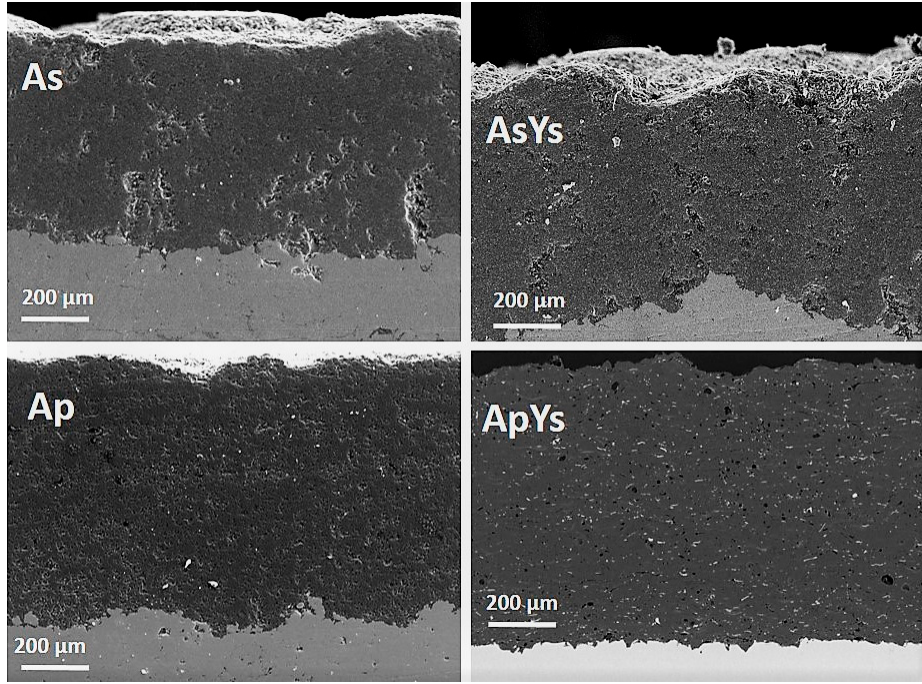
Figure 3. Cross-sectional SEM images of As, AsYs, Ap, and ApYs coatings.